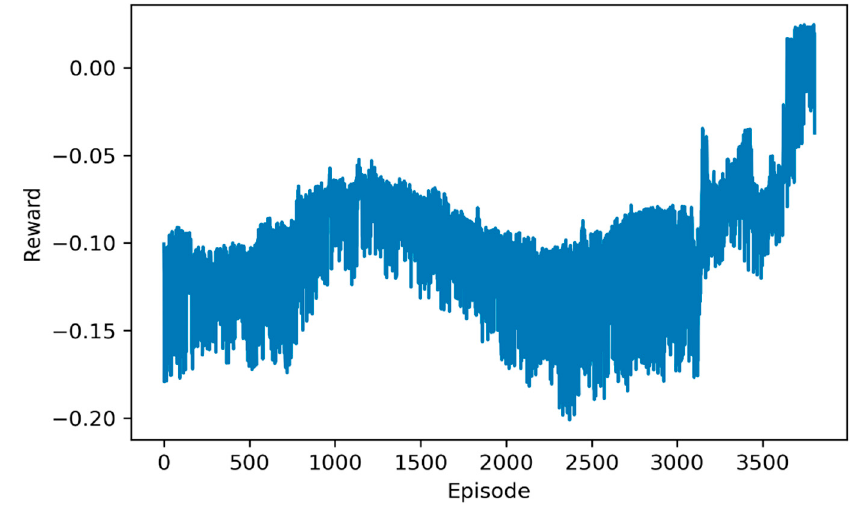
Figure 11. Rewards during the training process under continuously sampling random disturbances in the two-train network.